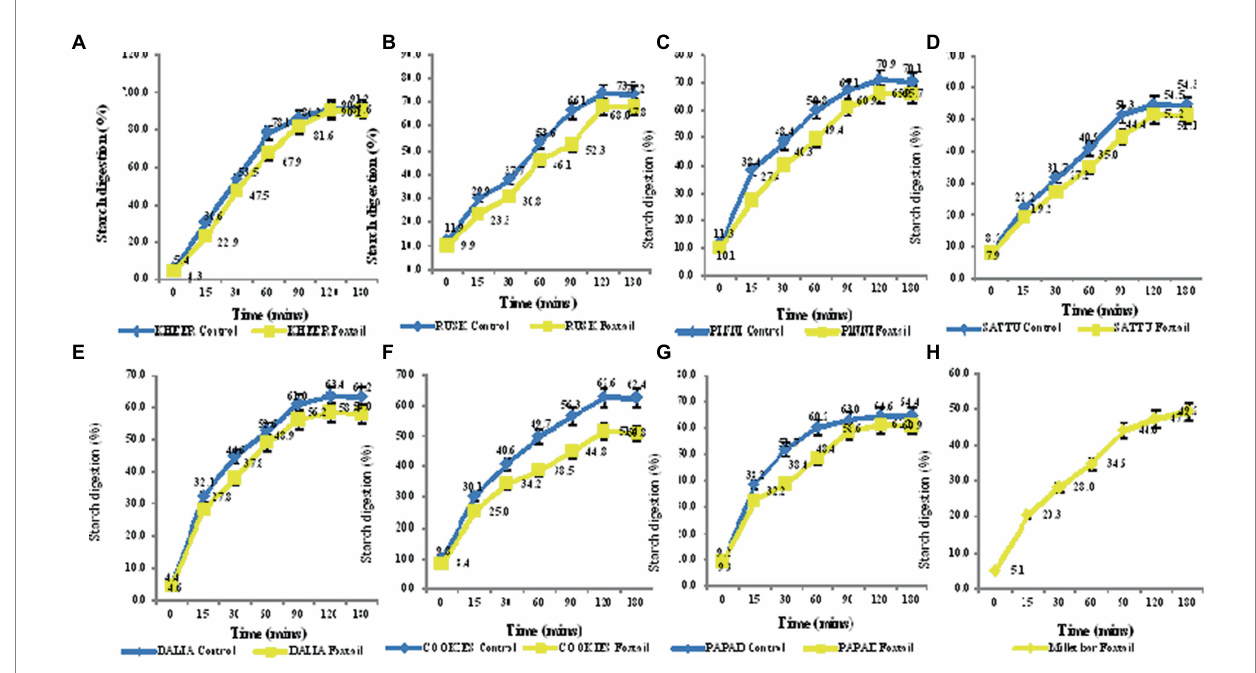
Values having different alphabetical superscripts represent significant difference ( p ≤ 0.05) among the products in the control and the experimental